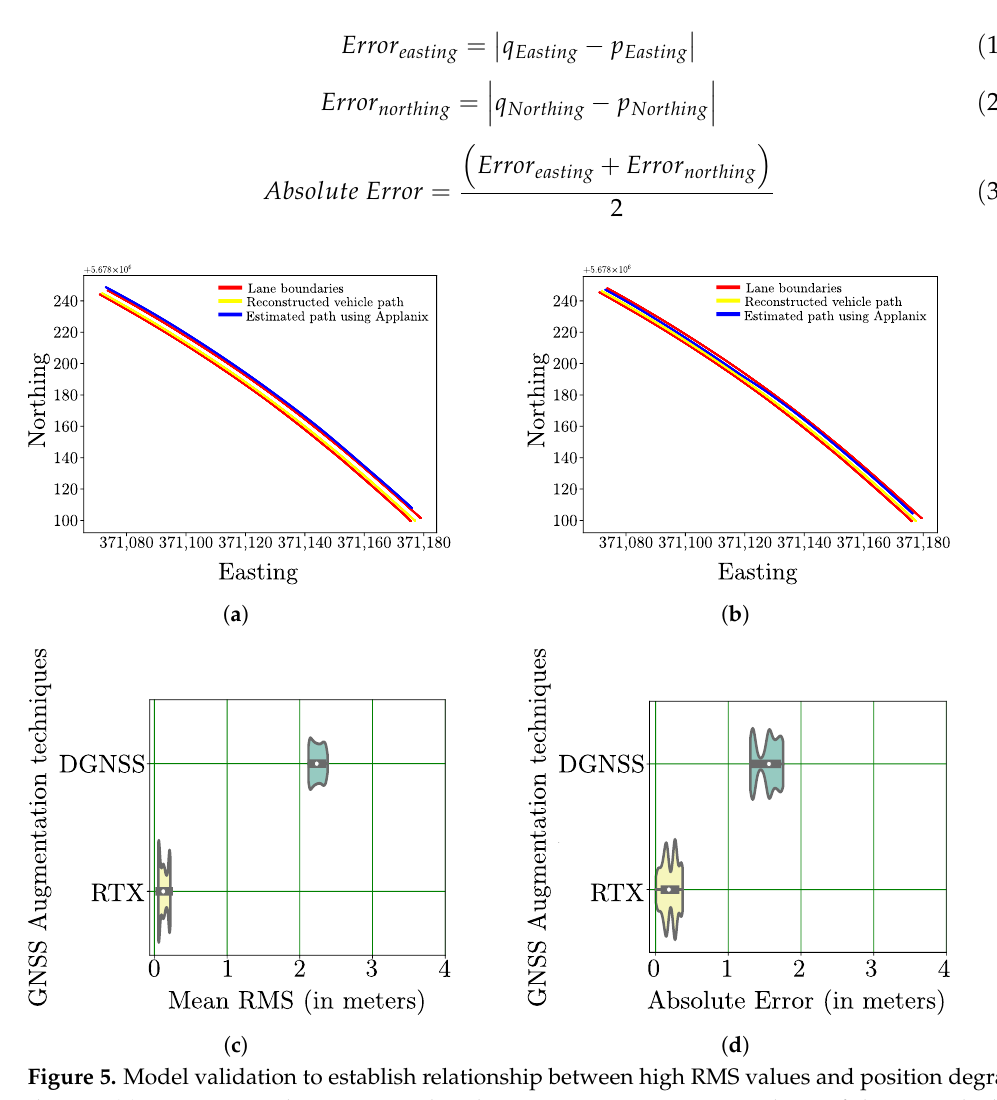
Figure 5. Model validation to establish relationship between high RMS values and position degra- dation. ( a ) Reconstructed Vs Estimated path using DGNSS position updates of the test-vehicle. ( b ) Reconstructed Vs Estimated path using RTX position updates of the test-vehicle. ( c ) Mean RMS as derived from Applanix POS LV-220 system. ( d ) Absolute Error as calculated by using reconstruction. In Figure 5c,d, violin plots showing the distribution of Mean RMS values estimated from the Applanix solution and the calculated Absolute Error for the selected region are provided. In a violin plot, a kernel density estimation is used to represent the distribution shape of data on either sides of the thin grey line. In particular, the wider sections are used to represent a higher probability that members of the population will take on the given value and the skinnier sections represent a lower probability. The thick grey bar in each violin represents the interquartile range and thin grey line indicates rest of point distribution excluding the outliers. Finally, the white dot represents the median